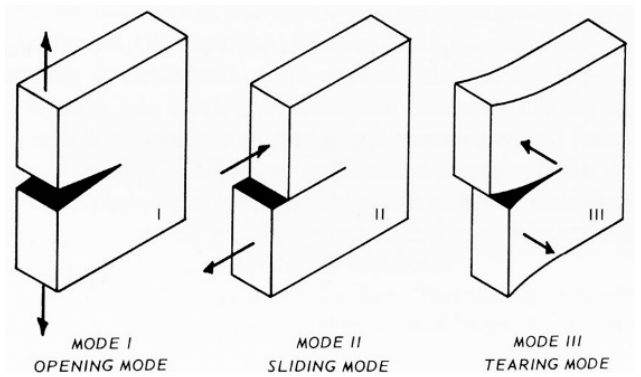
Figure 40. Modes of fracture.